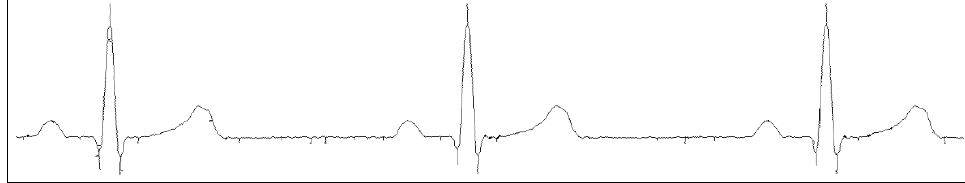
Figure 5. Binary mask of the cropped image (normal sinus rhythm, 60 bpm, II lead). After, the signal is thinned (see Figure 6) using the MATLAB function “bwmorph” with the operation “shrink”, which replaces groups of neighboring pixels with a single pixel. Experimentally, it was observed that, in order to reduce noise, the best result was obtained with its parameter set to 2.5, i.e., the number of times the “shrink” operation is performed.